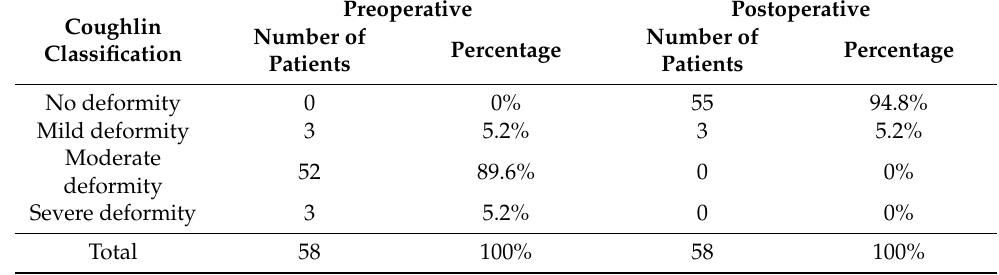
Table 3. Pre- and postoperative deformities according to Coughlin classification.